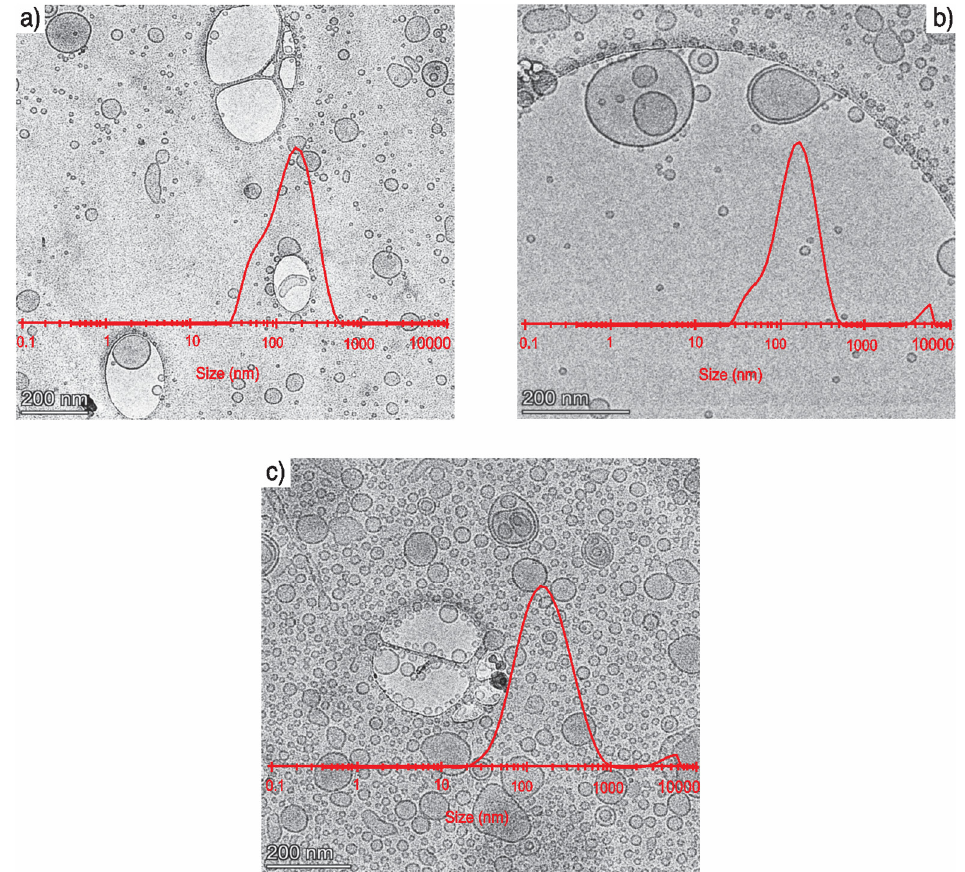
Figure 6. Transmission electron micrographs of liposomes. ( a ) The blank liposome contained DOPC:DOPA in a 1:1 M ratio. ( b ) The optimized liposome contained DOPC–DOPA (15.27